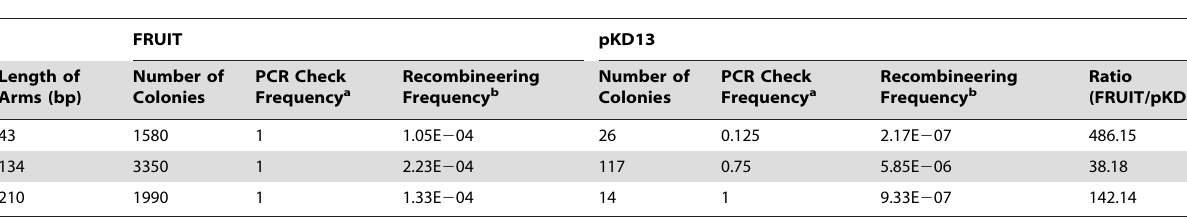
Table 2. Comparison of FRUIT to pKD13-mediated recombineering.